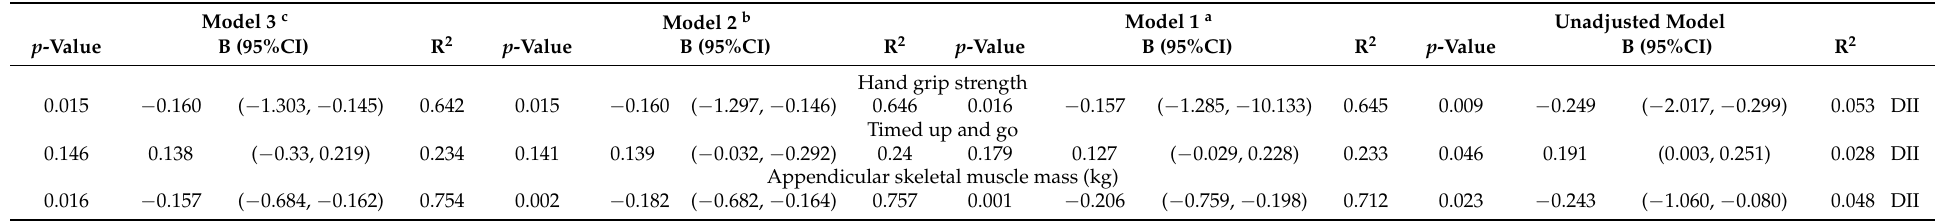
Table 3. Multiple linear regression coefficients expressing associations between markers of sarcopenia symptomology and physical frailty and Dietary Inflamma- tory